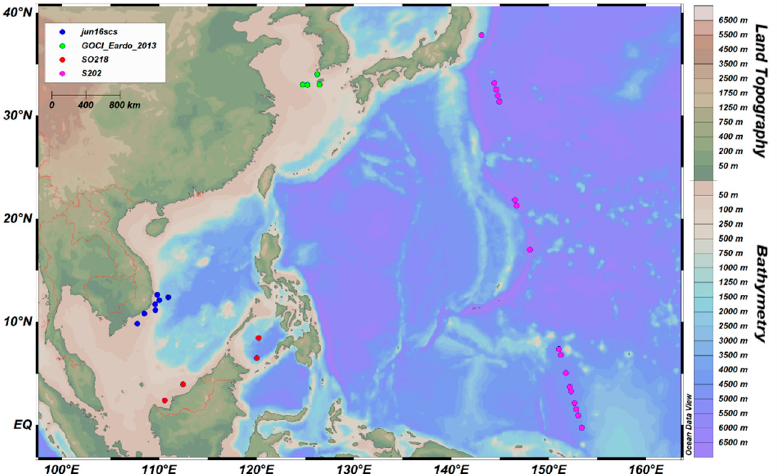
Figure 2. Locations of 32 in situ HPLC and synchronized satellite data, with the cruise name displayed in the legend.